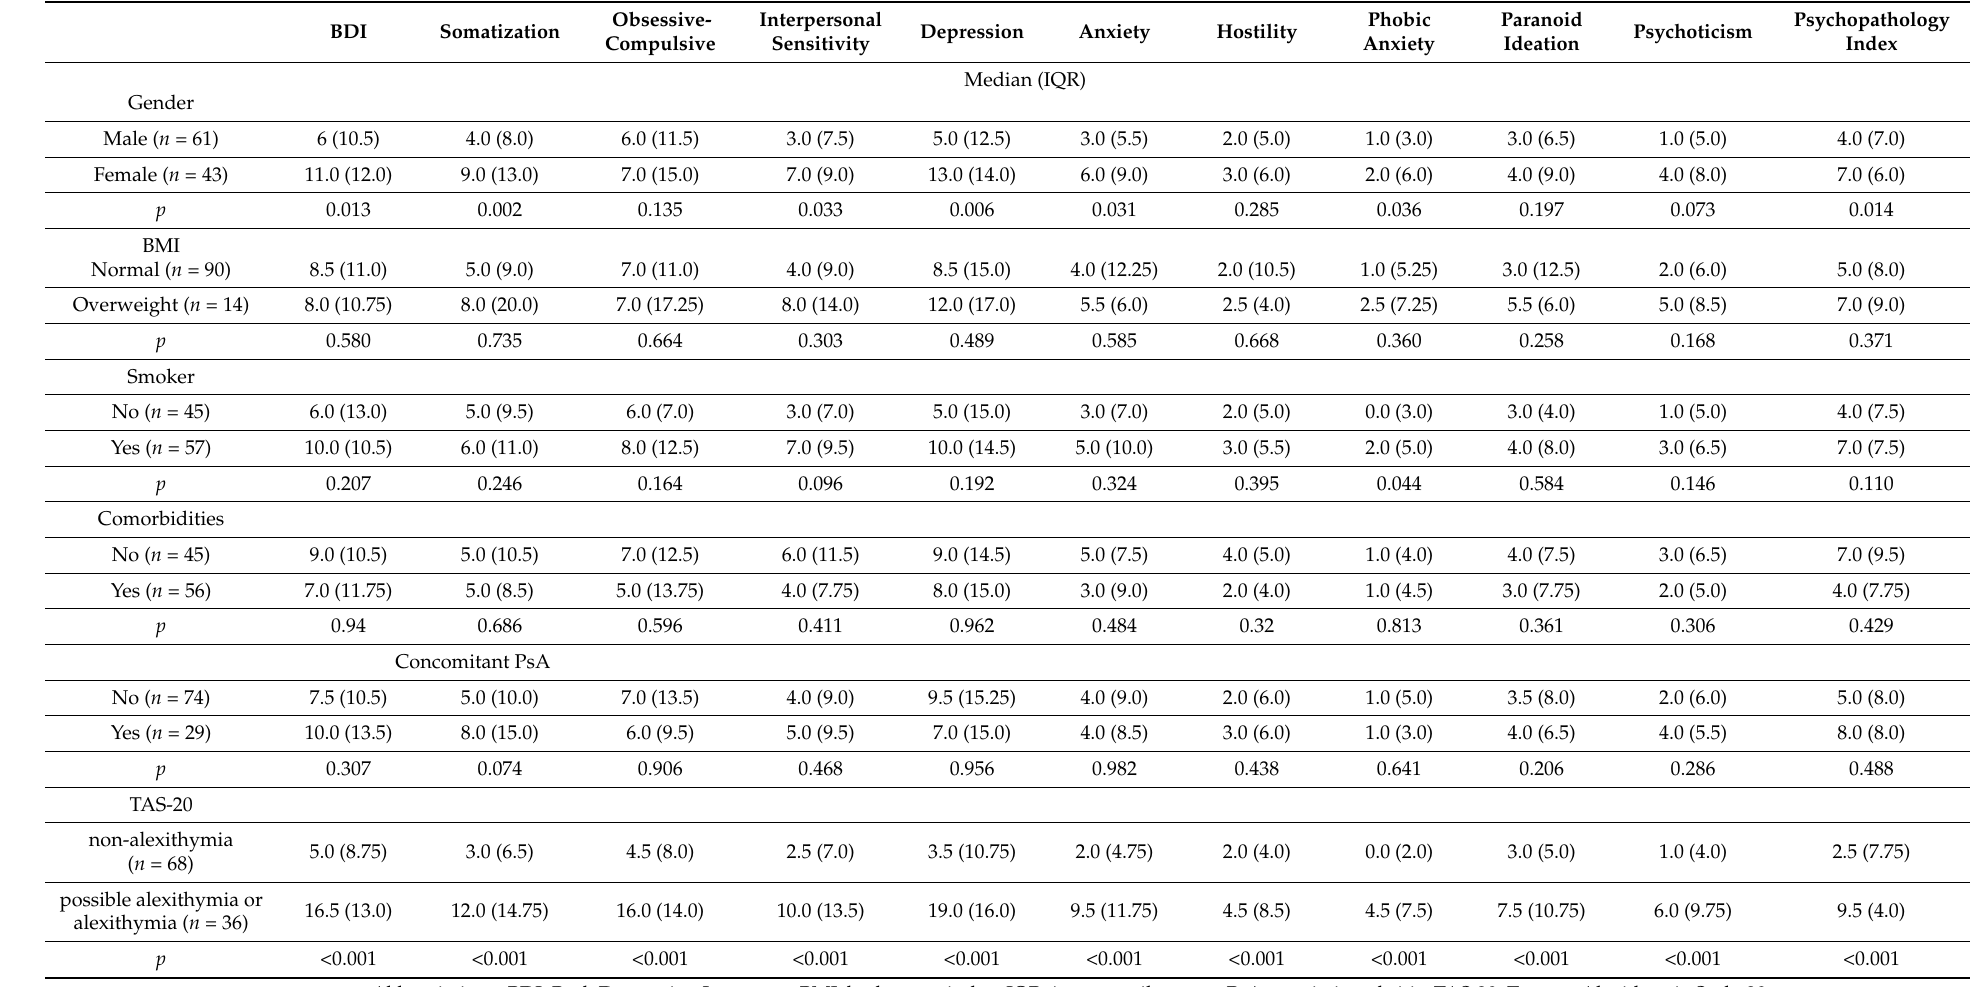
Table 1. Median, interquartile range (IQR), and differences in the BDI and SCL90 scales by demographic and clinical characteristics. BDI Somatization